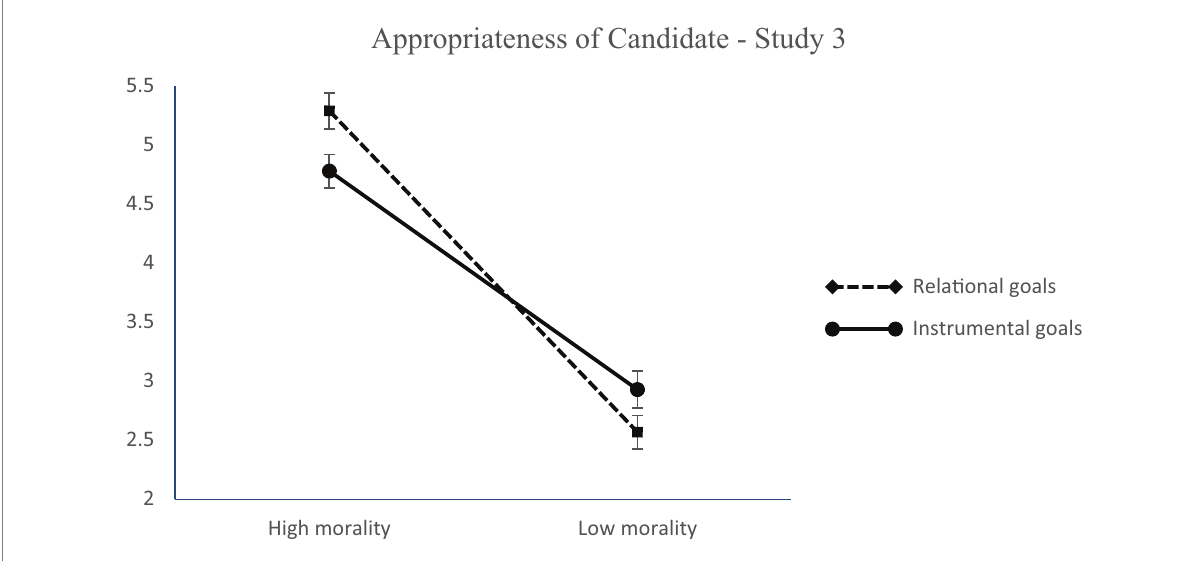
FIGURE 3 Perceived appropriateness of a candidate as a function of morality and type of goals (Study 3). Ratings were on a 7-point scale (1 = not at all , 7 = to a great extent ). Error bars represent standard errors.